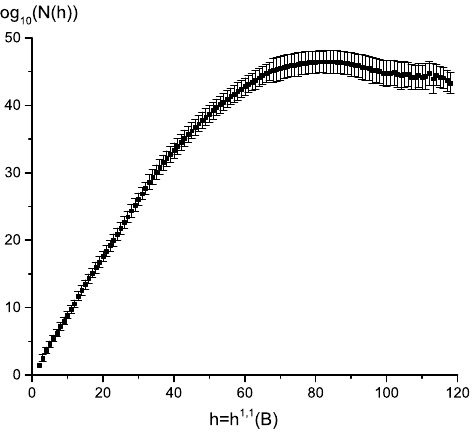
Figure 1 . log N of the number of bases with certain h 1 ; 1 ( B ) in the old Monte Carlo approach. 10 The average and error bar are computed among 100